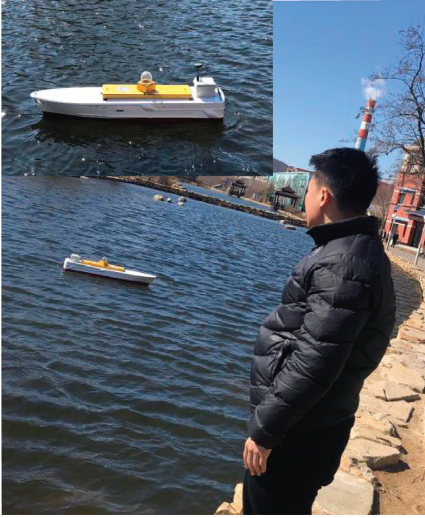
Figure 8: The scene of the